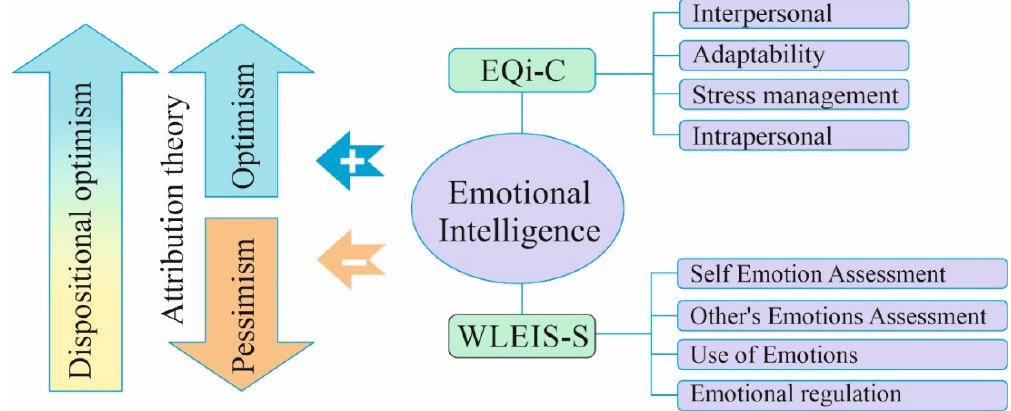
Figure 1. Proposed model of the relationship between EI and optimism–pessimism.